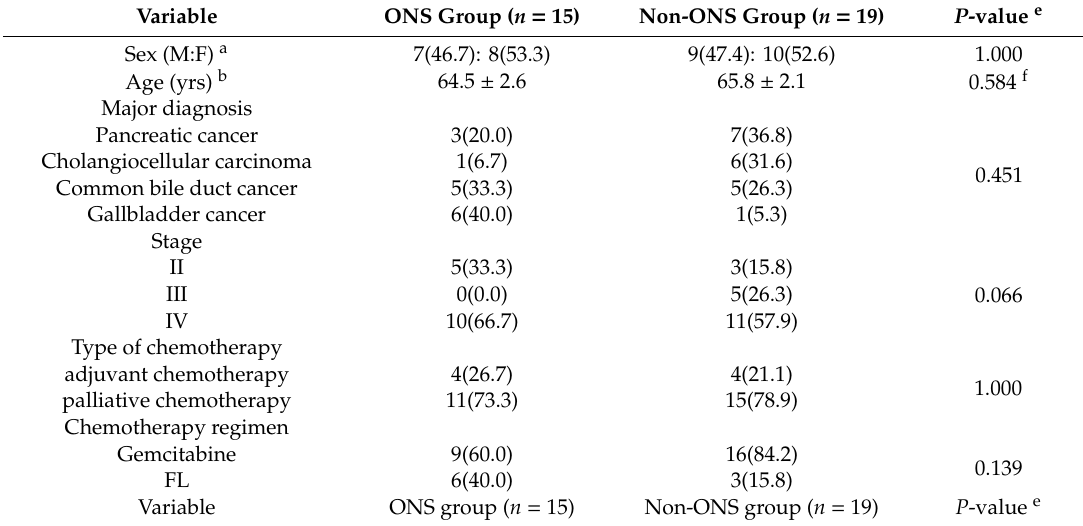
Table 1. Baseline characteristics of